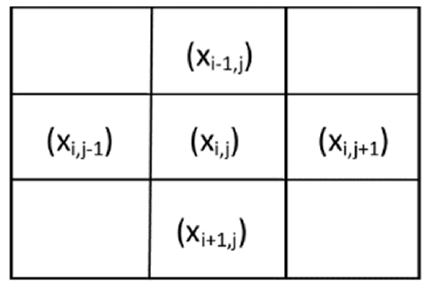
Figure 4. Nearest-neighborhood system.